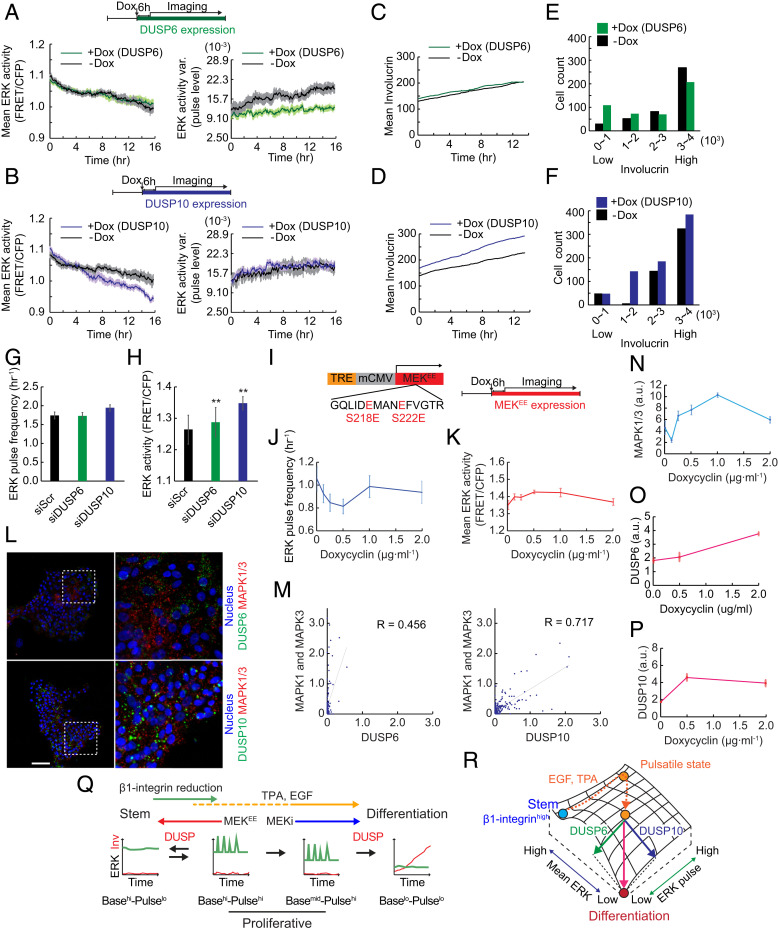
ERK pulse and mean levels are independently regulated by DUSP6 and DUSP10. (A and B) Mean (Left) and pulse levels (Right; see Materials and Methods) of ERK activity in NHKs treated with 1 µg/mL doxycyclin (green or purple) or vehicle (black). (A) DUSP 6 or (B) DUSP10 was induced by doxycycline treatment. Data are shown as mean ± SEM (n = 1,220 doxycyclin-treated cells and 1,261 vehicle-treated cells for A; n = 1,224 doxycyclin-treated cells and 1,005 vehicle-treated cells for B). (C and D) Involucrin expression over time in NHKs treated with 1 µg/mL doxycyclin (green or purple) or vehicle (black). (C) DUSP 6 or (D) DUSP10 was induced by the doxycycline treatment. (E and F) Cell numbers in the four bins of Involucrin-mCherry expression levels 18.5 h after doxycycline-induced DUSP6 and DUSP10 expression (green and purple, respectively) or vehicle (black) treatment. (G and H) ERK (G) pulse frequency and (H) mean ERK activity in NHKs treated with scrambled siRNA, siRNA against DUSP6, or siRNA against DUSP10. Data are shown as mean ± SEM (n = 5,701 siScr cells, 4,335 siDUSP6 cells, and 4,346 siDUSP10 cells, two-tailed unpaired Student’s t test; P values are indicated by **P < 0.01). (I) Construction of plasmid for doxycyclin-dependent expression of constitutively active MEK1 (MEKEE). For MEKEE induction, cells were treated with 0.125 μg/mL to 2.0 µg/mL doxycyclin. (J and K) ERK (J) pulse frequency and (K) mean ERK activity of NHKs treated with doxycycline to induce MEKEE expression. Data are shown as mean ± SEM (n = 1,140 ± 494 cells for each condition). (L) Representative images of RNA in situ hybridization of DUSP6 (Upper, green), DUSP10 (Lower, green), and MAPK1 and MAPK3 (red) transcripts. The Right images show enlarged views of the white-dotted squares in the Left images. (Scale bar: 100 μm.) (M) Dot plots and correlation analysis of DUSP6 (Left) or DUSP10 (Right), and MAPK1 and MAPK3 in situ hybridization signals in NHKs cultured for 5 d. Lines are regression lines, and values are Spearman’s rank correlation coefficient. Data are mean ± SEM (n = 66 cells for DUSP6 and 170 for DUSP10). (N–P) Quantification of RNA in situ hybridization signals of (N) MAPK1 and MAPK3, (O) DUSP6, and (P) DUSP10 in NHKs treated with doxycycline to induce MEKEE expression. Data are mean ± SEM (n = 202 ± 82 cells for N, 219 ± 115 cells for O, and 174 ± 44 cells for P). (Q) Schematic representation of the regulation of ERK dynamics. (R) Schematic representation of the regulation of ERK mean and pulse levels by DUSP6 and DUSP10 during differentiation.